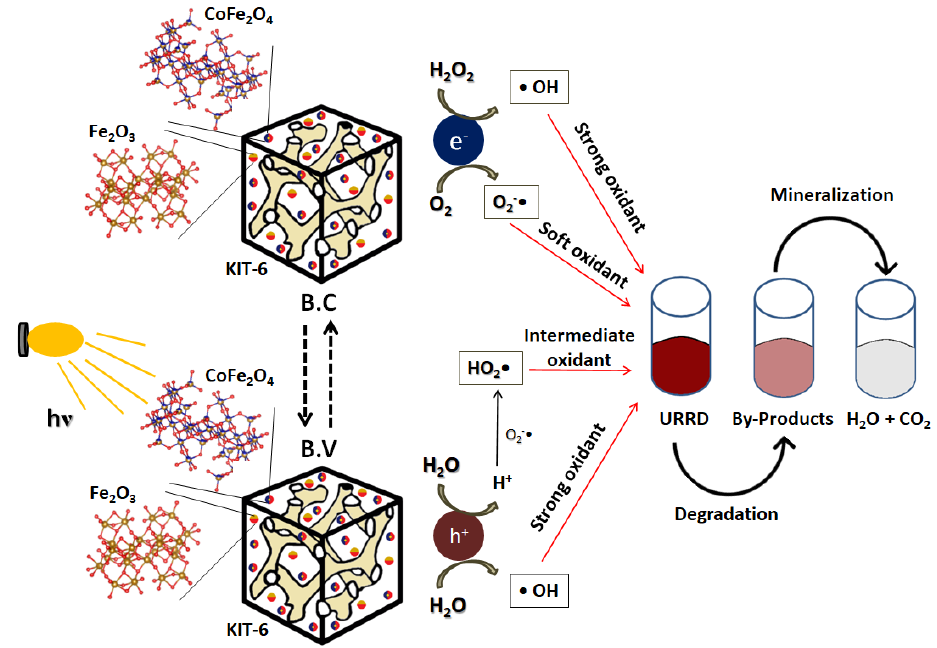
catalyst; Figure S5: The TiO 2 /CoFe 2 O 4 /Fe 2 O 3 –KIT-6 catalyst tests. (A) performance in the degrada- tion of the URRD dye and (B) kinetic parameter of the reaction; Figure S6. Degradation of the URRD dye. (A) CoFe 2 O 4 /Fe 2 O 3 –KIT-6 catalyst with H 2 O 2 ; (B) CoFe 2 O 4 /Fe 2 O 3 –KIT-6 catalyst without H 2 O 2 ; (C) TIO 2 /CoFe 2 O 4 /Fe 2 O 3 –KIT-6 catalyst without H 2 O 2 ; (D) TIO 2 /CoFe 2 O 4 / Fe 2 O 3 –KIT-6 catalyst with H 2 O 2; (E) TiO 2 /KIT-6 with H 2 O 2; Figure S7. Degradation of the URRD dye in the reuse tests; Table